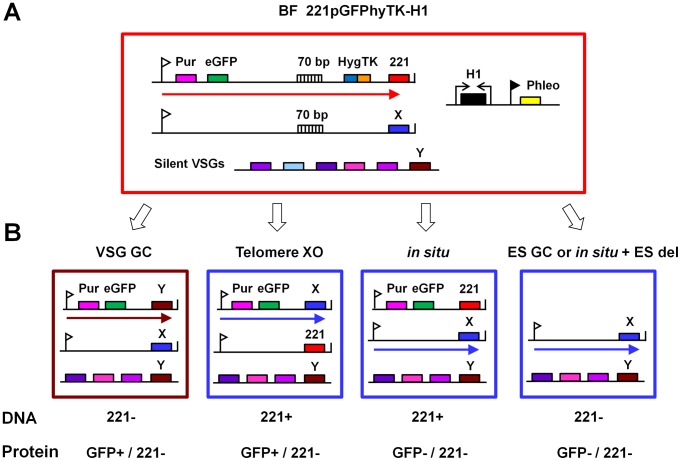
Strategy for determination of VSG switching frequencies after blocking histone H1 synthesis.
A. Diagram of the BF T. brucei 221pGFPhyTK-H1 cell line used for analysis of VSG switching after histone H1 knock-down. The large red box indicates a cell, with a construct containing the puromycin (Pur) resistance gene and eGFP integrated immediately behind the active VSG221 ES promoter (indicated with a flag). A construct containing a fusion protein for hygromycin resistance and thymidine kinase (HYGTK) activity is integrated at the telomeric end of the ES between characteristic 70 bp repeat sequences (70 bp) and the telomeric VSG221 gene. A silent ES with an unknown VSG (X) is indicated below, as well as chromosome internal silent VSGs (Y) located in tandem arrays. A construct allowing transcription of histone H1 RNAi (H1) from opposing T7 promoters (arrows) as well as a phleomycin (Phleo) gene transcribed from an rDNA promoter (black flag) has also been introduced. B. Schematic of VSG switching mechanisms detectable in our assay, adapted from [66]. Switching the active VSG can be mediated through a VSG gene conversion (GC), telomere exchange (XO), or in situ activation of another ES (in situ). In addition, VSG switch events resulting in loss of the VSG221 ES by either gene conversion (ES GC) or a deletion event after an in situ switch (in situ+ES del) were identified. Each type of VSG switch event, in addition to mutations in the TK gene itself (not shown), result in resistance to ganciclovir (GCV). Presence of the single copy VSG221 gene is indicated below (DNA). In addition, expression of the GFP or VSG221 protein are indicated. The schematic is labeled as indicated in panel A.